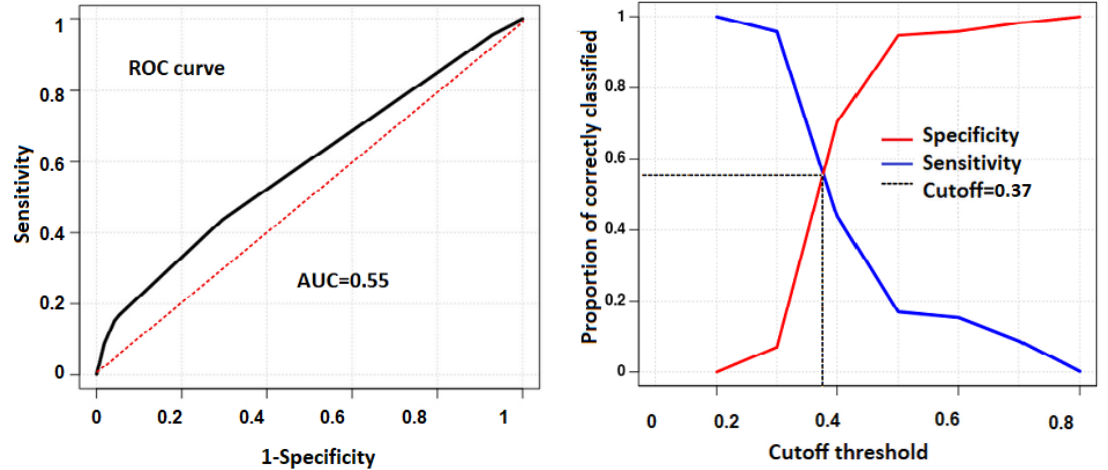
Figure 12. ROC curve ( a , c ), area under the AUC curve ( b , d ) and optimal cut-off value of the models: XGBoost-LR and logistic regression, respectively, to estimate the risk of suffering from